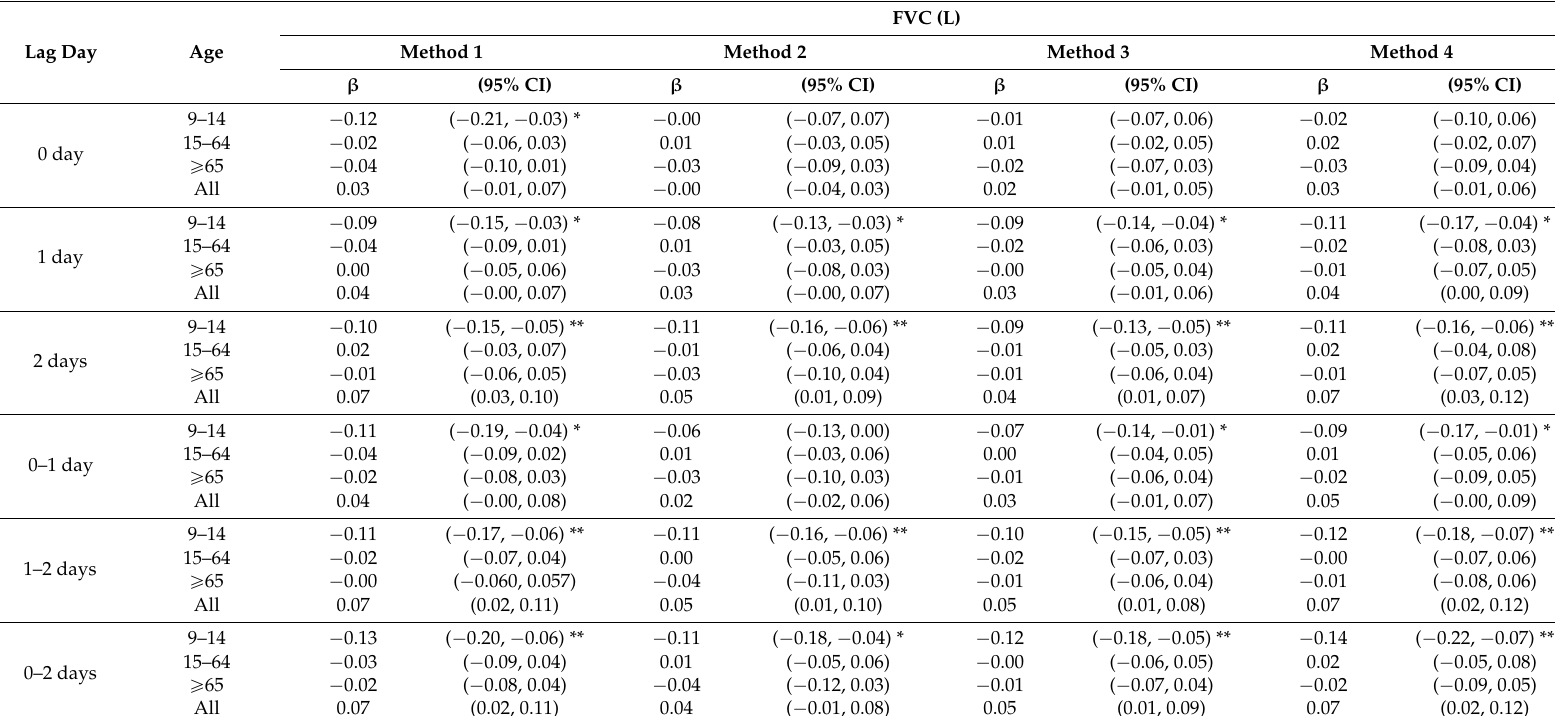
Table 5. Age-specific effect of change in FVC (L) per increase IQR † of O 3 concentration by various lags and four methods for estimating